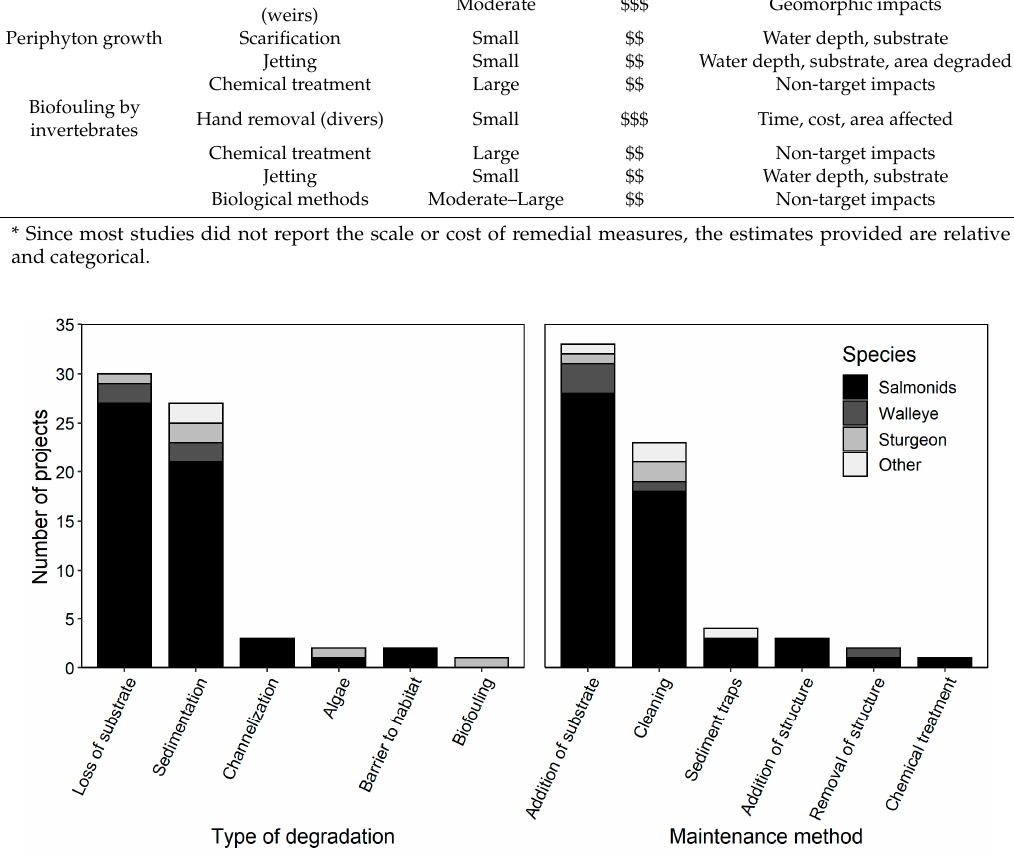
Figure 2. Number of rocky spawning habitat maintenance projects by type of degradation, maintenance method, and target taxa. Note that each project may have more than one type of degradation and/or maintenance method.